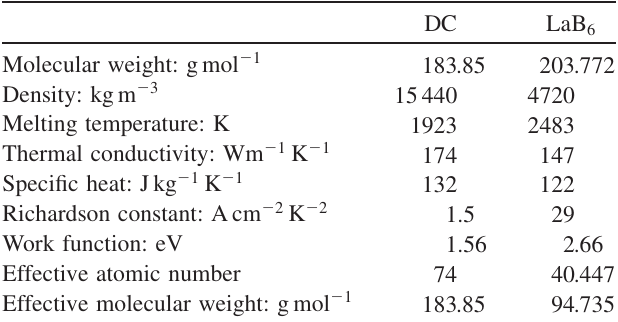
TABLE I. DC and LaB